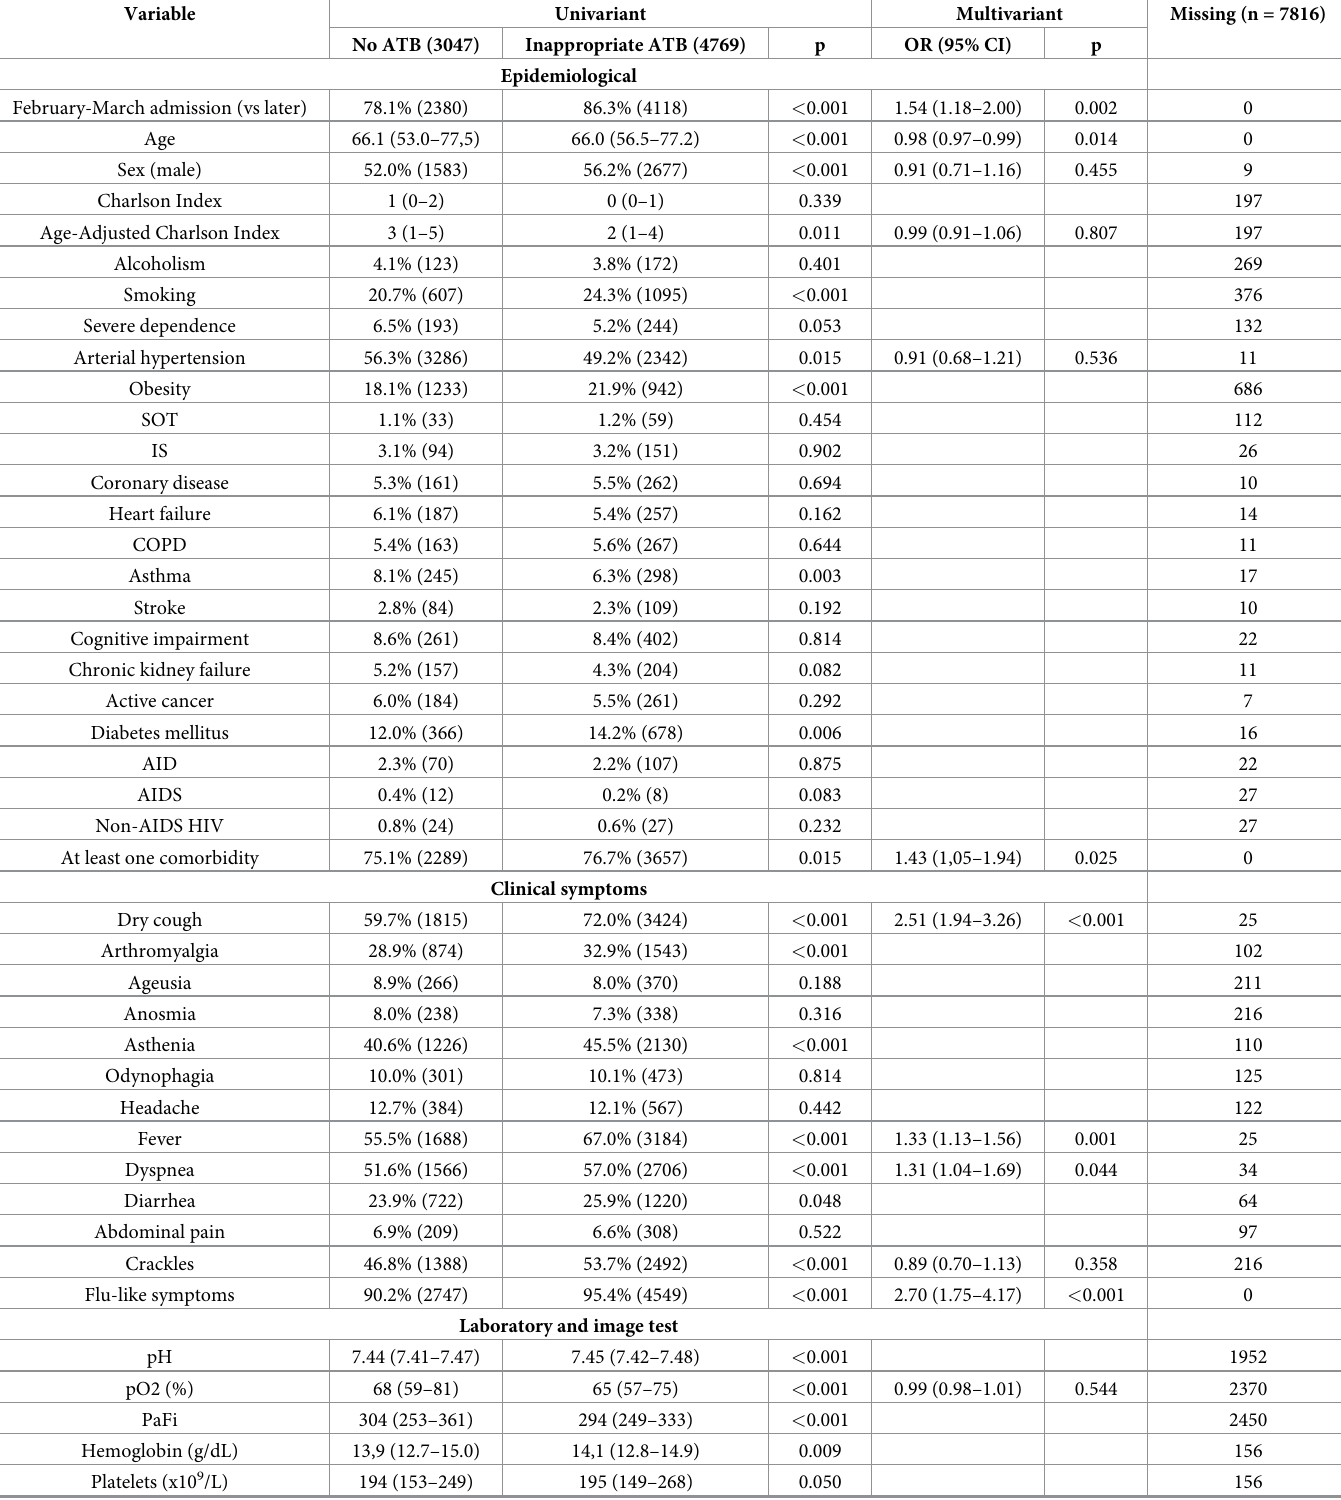
Table 3. Epidemiological, clinical and analytical characteristics according to non-prescription or inappropriate prescribing of